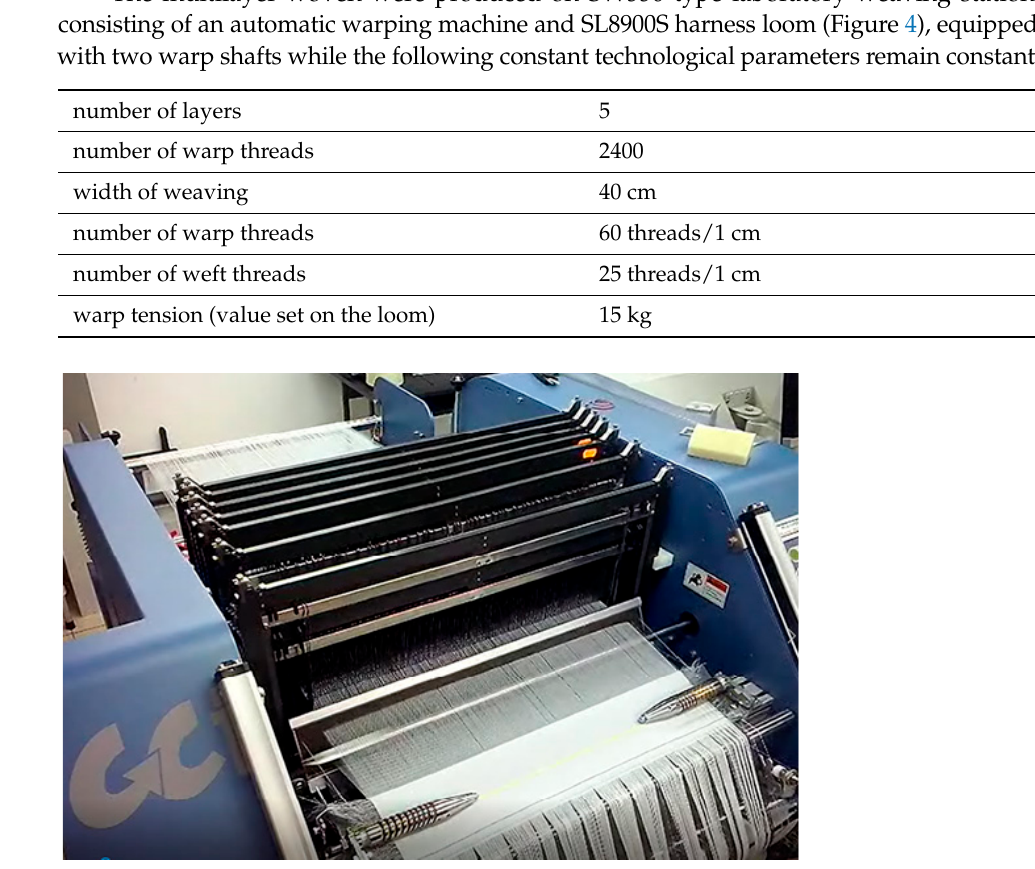
Figure 4. The laboratory harness loom during manufacturing of MLW. Table 2. The tensile test results for used yarn.